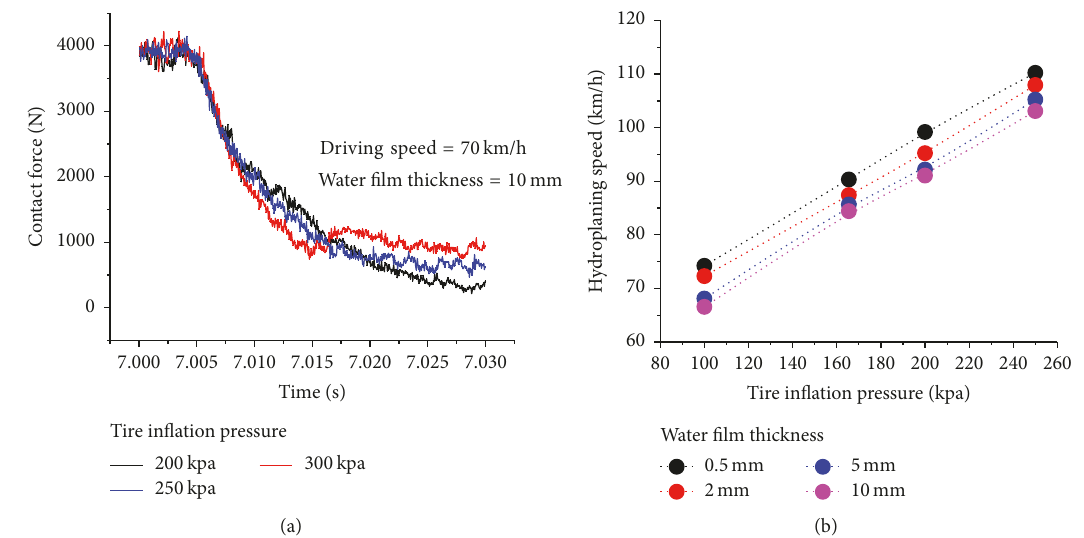
Figure 13: Contact force and hydroplaning speed influenced by tire inflation pressure: (a) contact force; (b) hydroplaning speed.